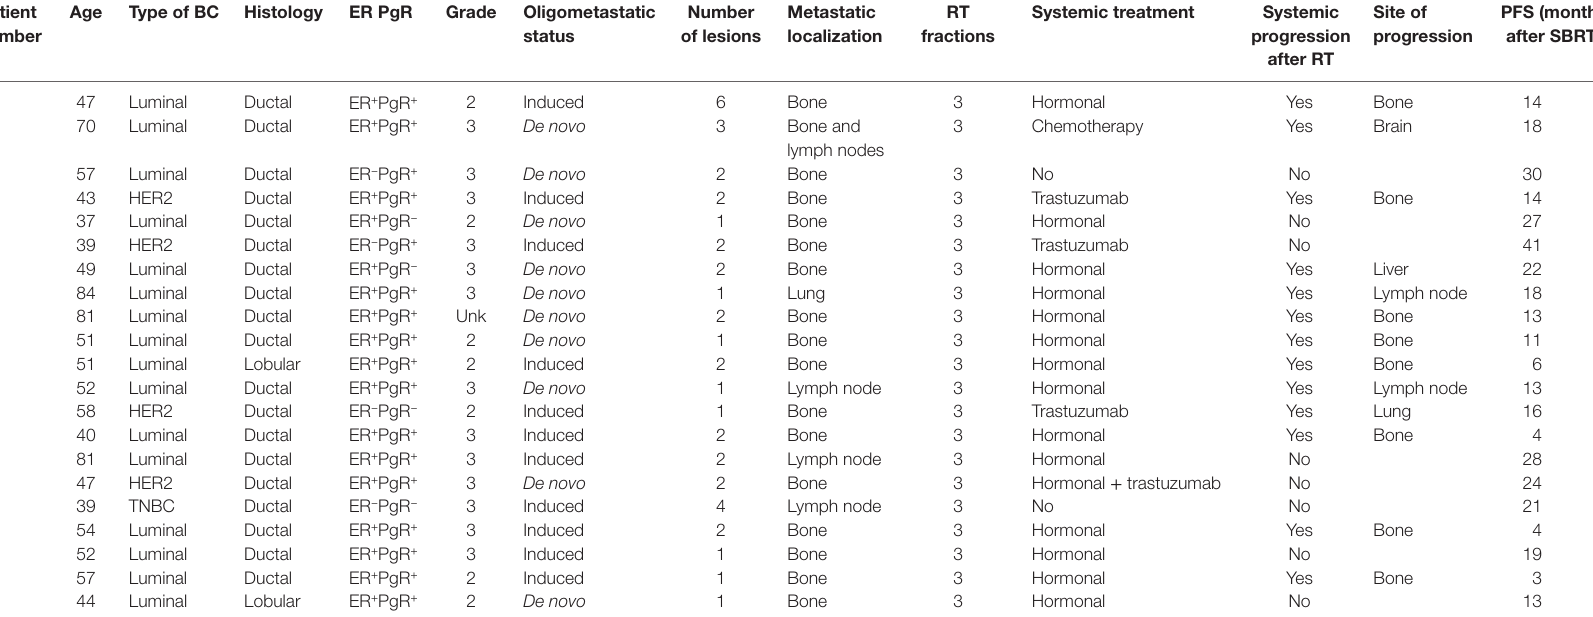
TaBle 1 | Patient